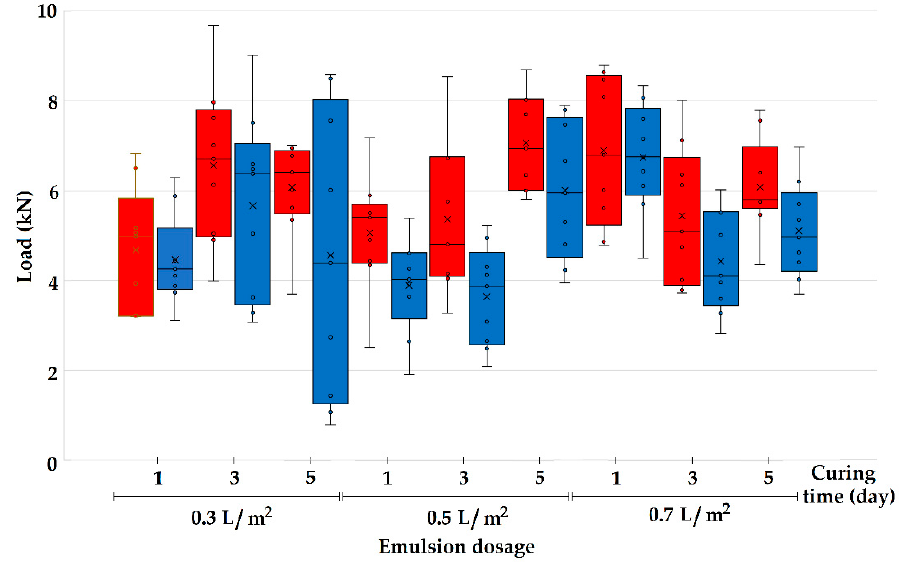
Figure 6. Box and whisker chart of the specimen adhesive bond.